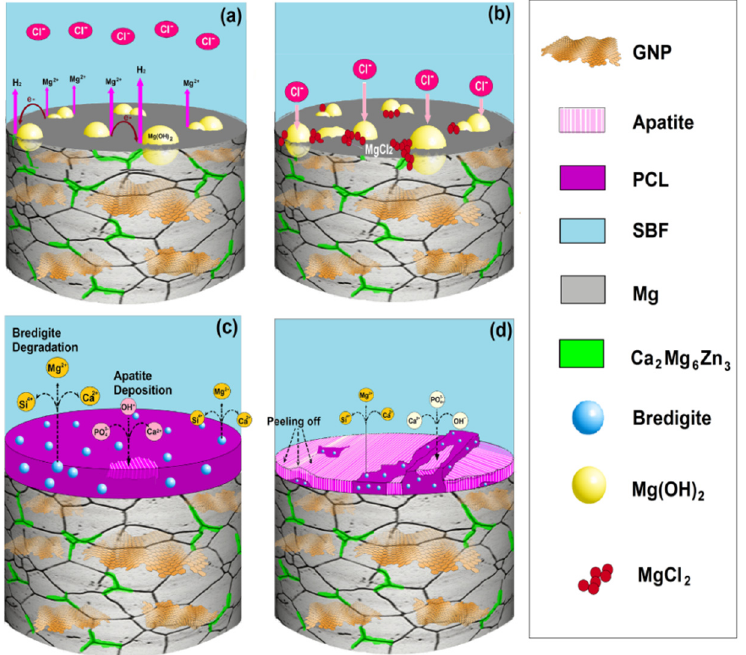
Figure 6. Schematic of the surface reaction with the SBF of ( a , b ) the bare sample and ( c , d ) PCL- bredigite-coated Mg-based composite sample. Reprinted with permission from [19]; Copyright 2020 Elsevier.